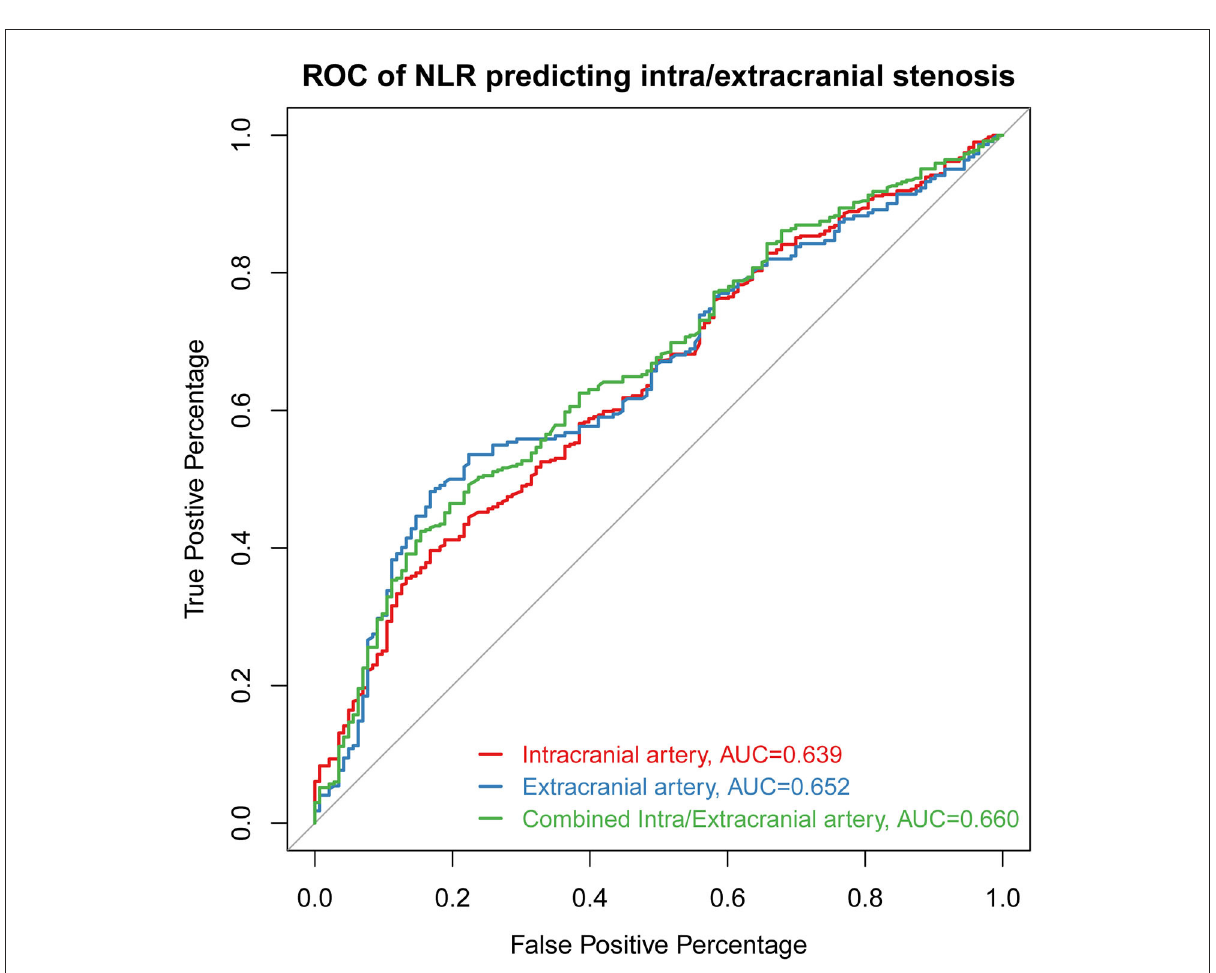
FIGURE3 The ROC curve of NLR for predicting intracranial stenosis, extracranial stenosis, and combined intracranial and extracranial stenosis. ROC, receiver operating characteristic curve; AUC, area under the curve; NLR, neutrophil-to-lymphocyte